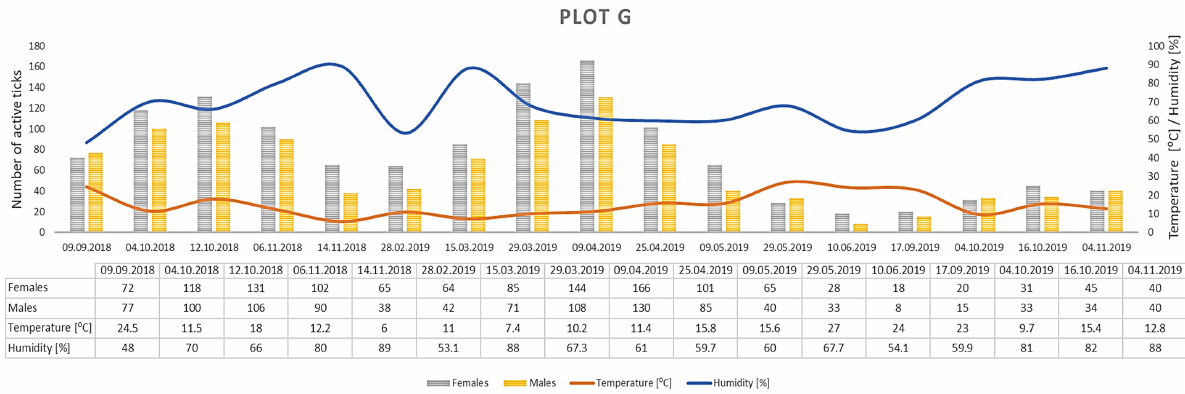
Figure 8. Abundance and seasonal activity of Dermacentor reticulatus adults in research plot F and weather conditions prevailing during tick collection. Predominance of active ticks in autumn.